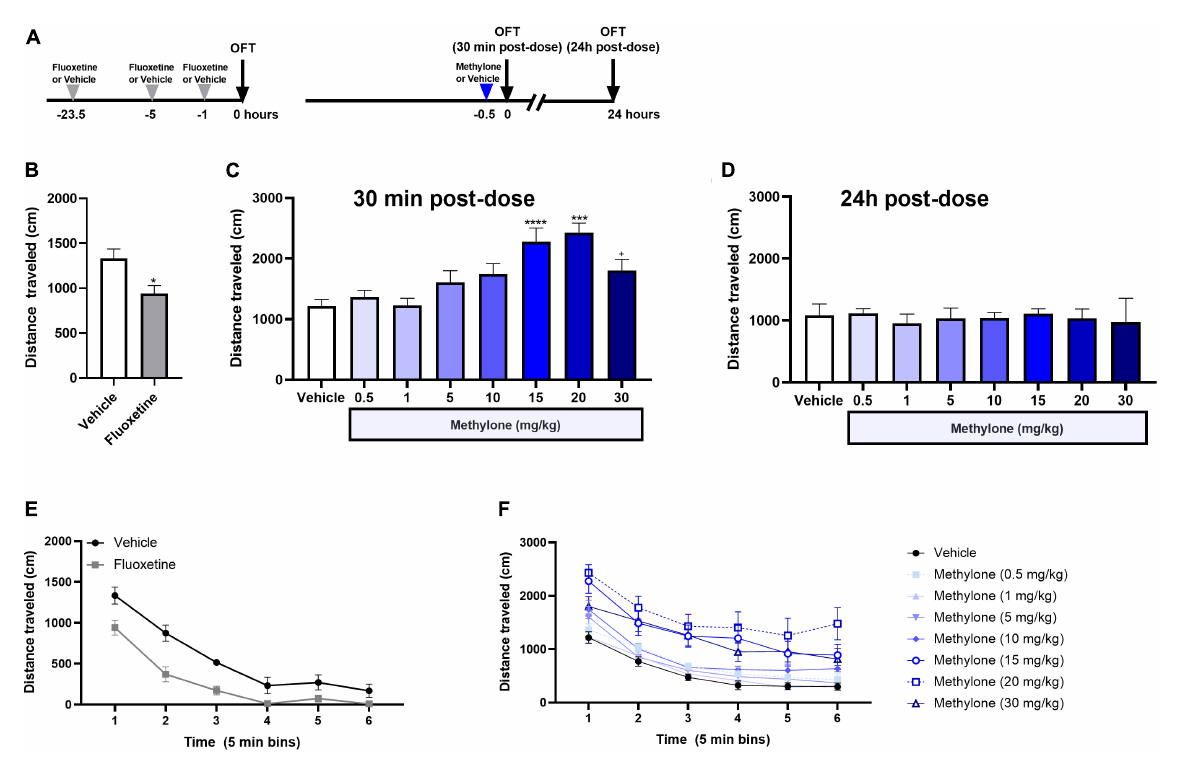
FIGURE4 Effects of methylone on locomotor activity. (A) Schematic showing that the doses and time points tested in the OFT mirrored those used in FST dose response study. (B) Fluoxetine (10 mg/kg, IP) or saline (Vehicle) were administered 23.5, 5, and 1 h prior to testing, and the total distance traveled in the OFT is shown for the first 5-min of the test, corresponding to the testing duration in the FST. (C) Methylone (0.5–30 mg/kg, IP) or saline (Vehicle) was administered 30 min prior to testing, and the total distance traveled in the OFT is shown for the first 5 min of the test. (D) Effects of methylone on distance traveled for the first 5 min in the OFT were measured 24 h post-dose. Total distance traveled is shown for the duration of the 30-min OFT testing session in 5-min time bins after (E) fluoxetine or (F) methylone treatment. Data are presented as means ± SEM. * p < 0.05, *** p < 0.001, **** p < 0.0001 vs. Vehicle control group, Bonferroni’s post-hoc test N = 6 for fluoxetine; N = 7–13 per group for methylone. + p = 0.08.